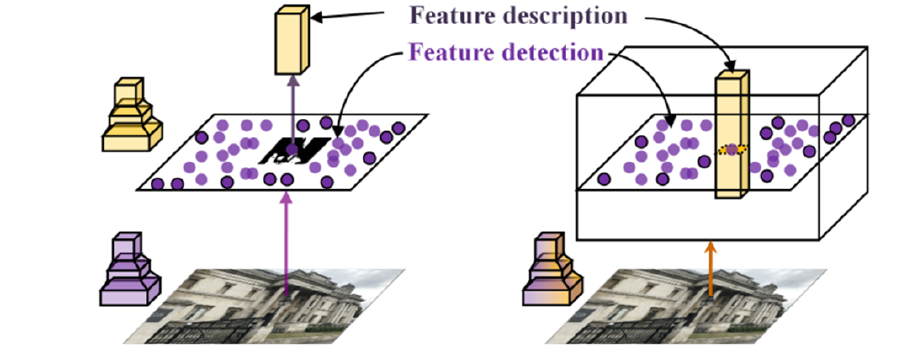
Figure 8. Difference between D2Net and the traditional